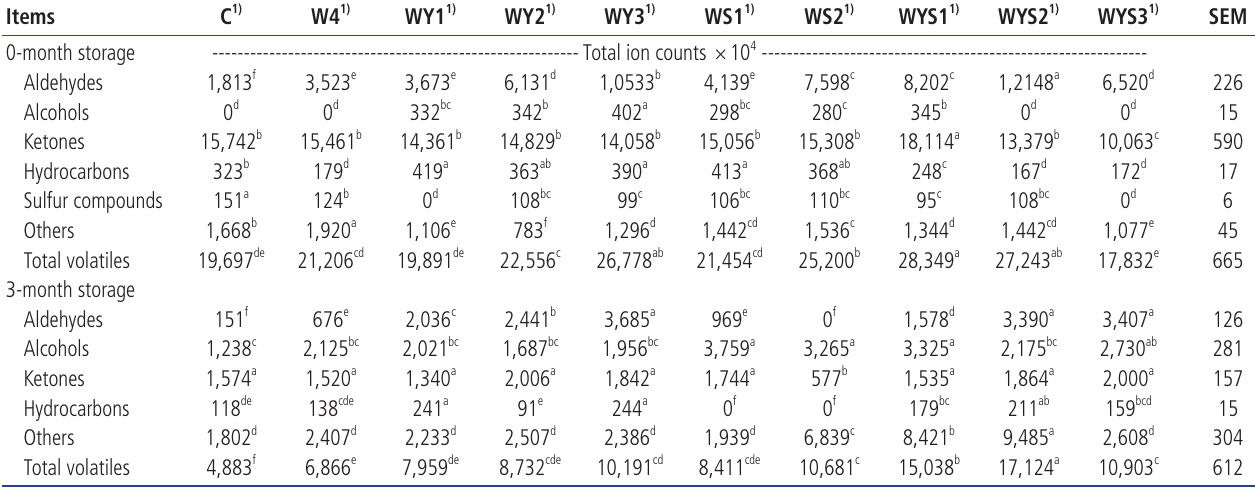
Table 6. The volatile compounds of non-dairy creamers with different formula and storage time Items